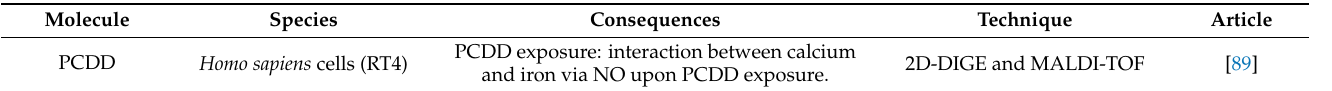
Table 7. Articles describing other POP-induced